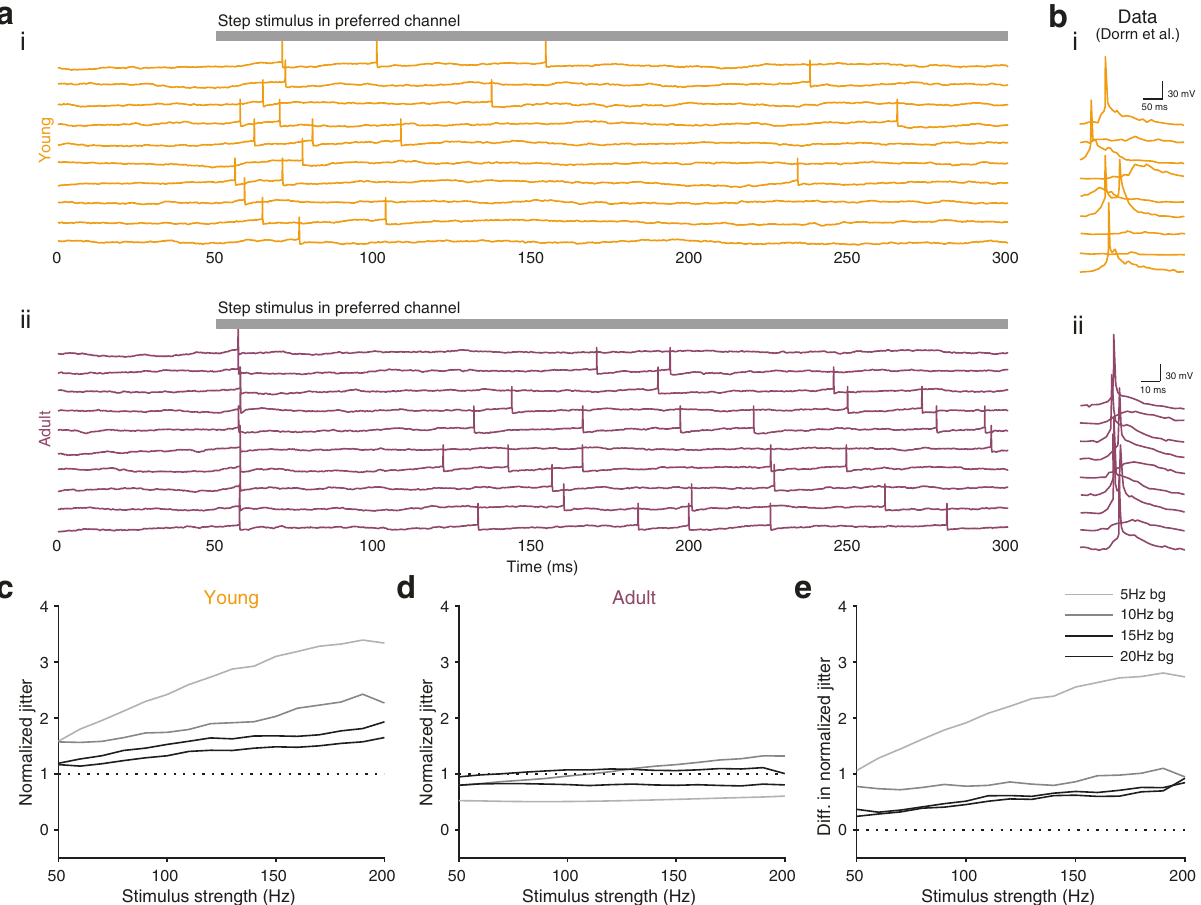
Fig. 6 Adult STP improves temporal precision of postsynaptic spikes. a Examples of postsynaptic voltage responses with preferred channel input for both young STP model (i) and adult STP model (ii); gray bar at top represents time during which preferred channel is stimulated. b Stimulus evoked responses in in vivo recordings across a few trials in young (i) and adult (ii) animals. Panels adapted from a previous study 26 . In a , b the background fi ring rate is 5 Hz. c , d Normalized jitter of postsynaptic spikes in the young ( c ) and adult ( d ) model for different background fi ring rates (denoted by different shades of gray; see Methods; cf. Fig. S12 and Fig. S16). e Difference between normalized jitter of young STP model ( c ) and adult STP model ( d